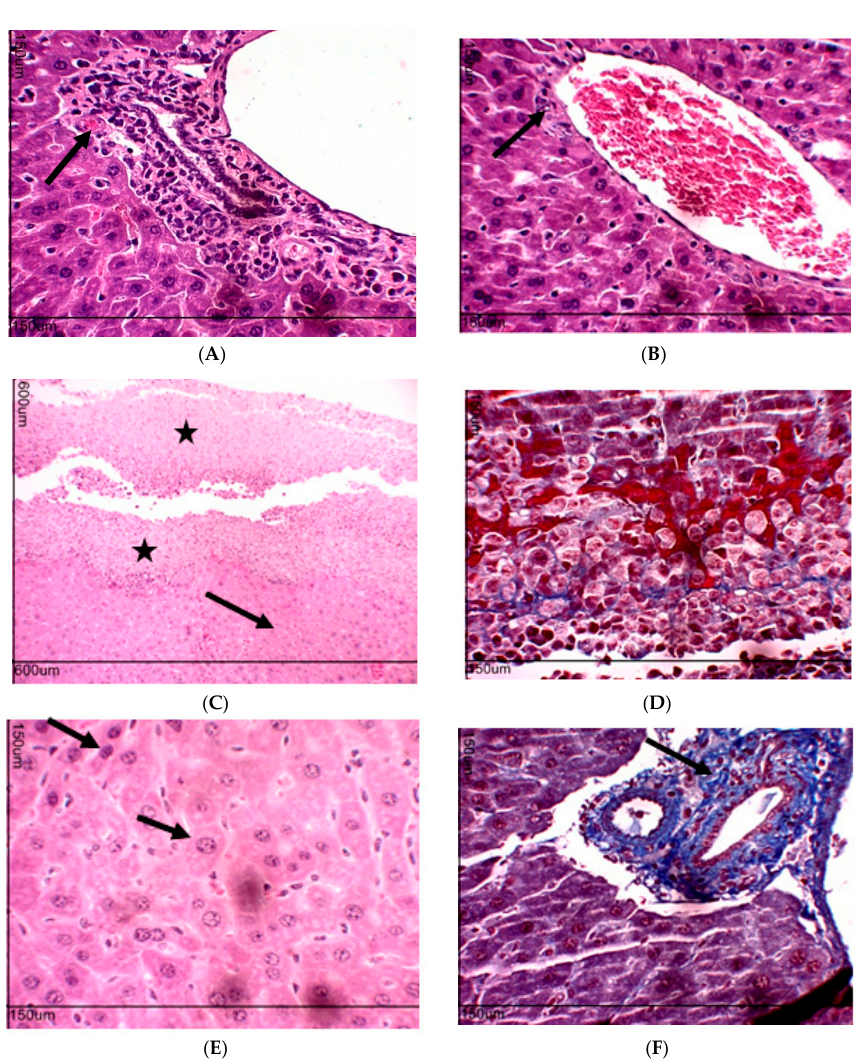
Figure 7. Histopathology of the kidneys of different groups: ( A ) Control, cortical region, renal glomerulus (arrow) and cortical labyrinth (star). ( B ) Control, medullary region, collecting tubules (star), loop of Henle and vessels straight (arrow). ( C ) Group 5-FU, cortical region, glomerulus (arrow) and cortical labyrinth (star). ( D ) Group HE-02 (12.5 mg/kg), subcapsular region, cell infiltrate (arrow). ( E ) Group HE-02 (12.5 mg/kg), cortical region, renal corpuscle (arrow) and cortical labyrinth (star). ( F ) Group HE-02 (12.5 mg/kg), medullary region, loop of Henle and medullar rays (arrow), collecting tubules (star). A, B, C, D, E and F-HE, A.T. ×400. The livers removed from tumor control groups presented within normal parameters, although cellular infiltrate observed around the hepatic duct (Figure 8A). Cellular infiltrate was smaller in the 5-FU (Figure 8B) and HE-02 groups (Figure 8C). For the HE-02 group, cellular infiltrate was observed in the subcapsular region of the Glisson capsule (hepatic capsule) (Figure 8C) with presence of mononuclear cells and apoptotic cells forming apoptotic bodies (Figure 8D). Hepatocytes showing changes in nucleus size and dye affinity were observed by alterations in cytoplasmic staining and hepatocyte nucleus (Figure 8E). In addition, cellular infiltrate was observed in the portal space (Figure 8F).